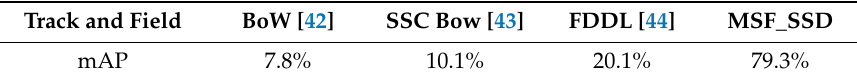
Figure 12. ROCs of SSD and MSF_SSD on test samples. Table 4. The mAP of the object detection